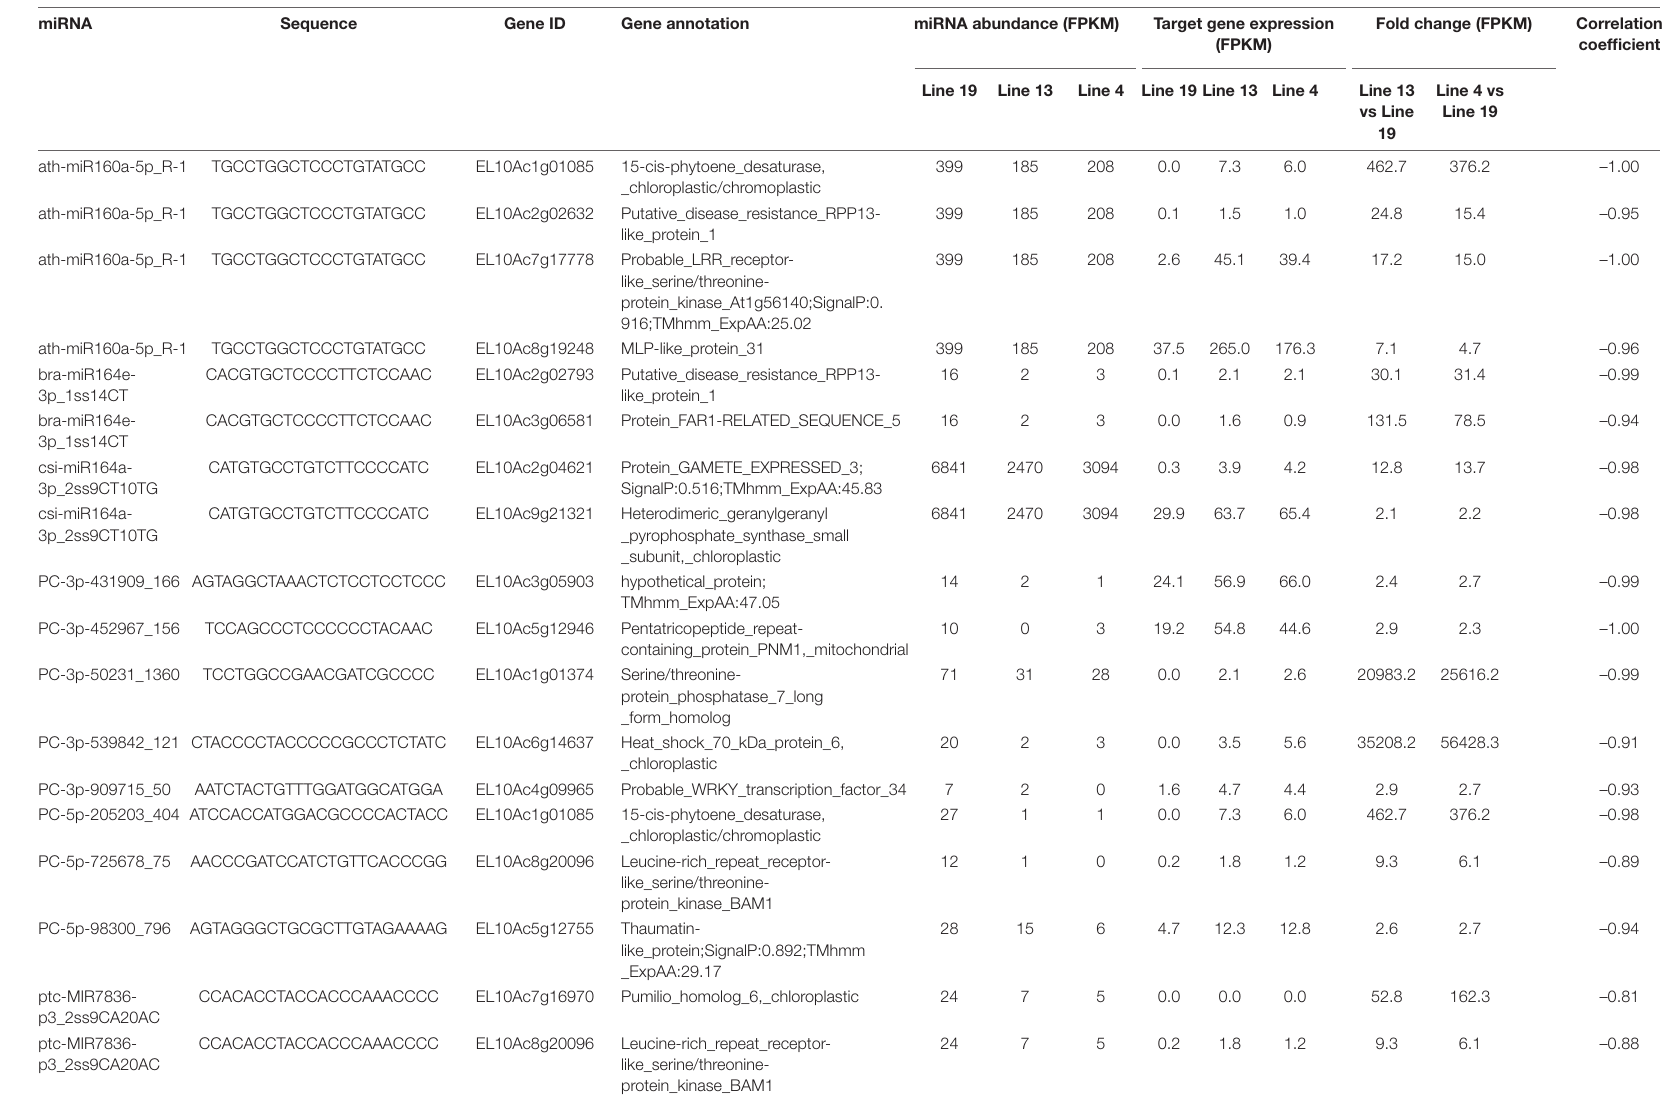
TABLE 4 | Sugar beet miRNAs that showed < 2-fold expression in the apical leaves of BCTV resistant (13, 4) vs. susceptible lines (19) at 6 dpi and effect on corresponding sugar beet target gene expression. miRNA Sequence Gene ID Gene annotation miRNA abundance